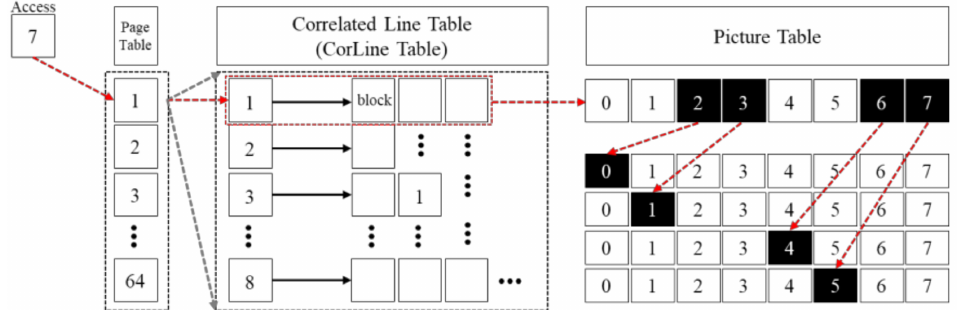
Figure 3. Update flow of picture